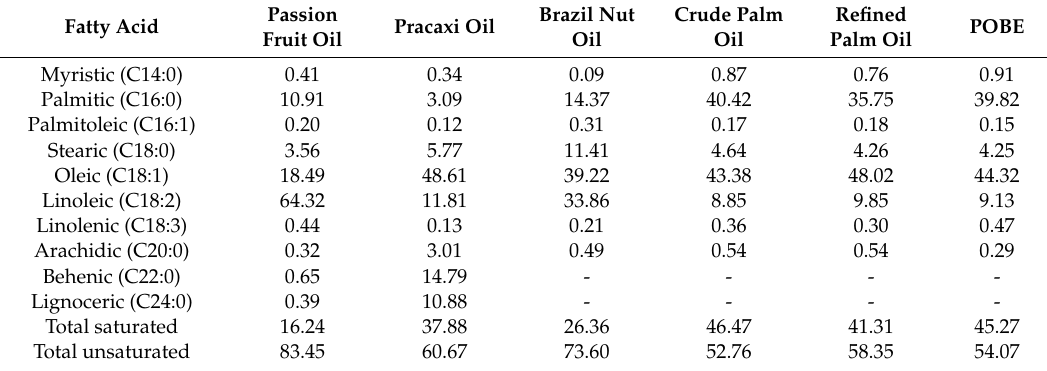
Table 1. Fatty acid composition (%) of the palm oil bleaching extract (POBE) compared with those of vegetable